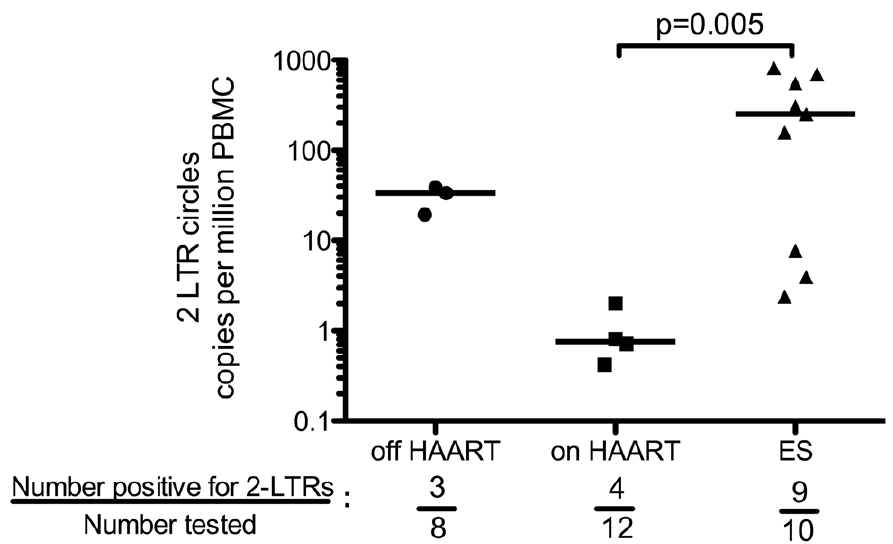
Figure 5. ES patients harbor higher levels of 2-LTR circles than HIV + patients on HAART. DNA samples from ten ES patients were analyzed for 2-LTR circular HIV DNA. 2-LTR circular HIV DNA levels were compared to those in samples from HIV + patients on and off-HAART. Only ES and on HAART could be compared due to small samples size. The level of 2-LTR circles was higher in ES as was the frequency with which they were detected (p=0.007, chi-square test). The line represents the median value.